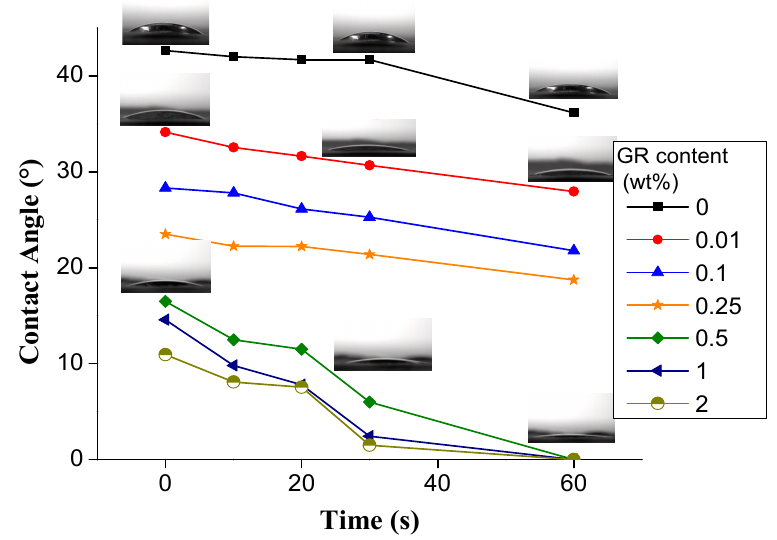
Figure 4. Dynamic hydrophilicity angle of PVA/GR nanofiber films as related to the content of graphene. Materials 2018 , 11 , x FOR PEER REVIEW